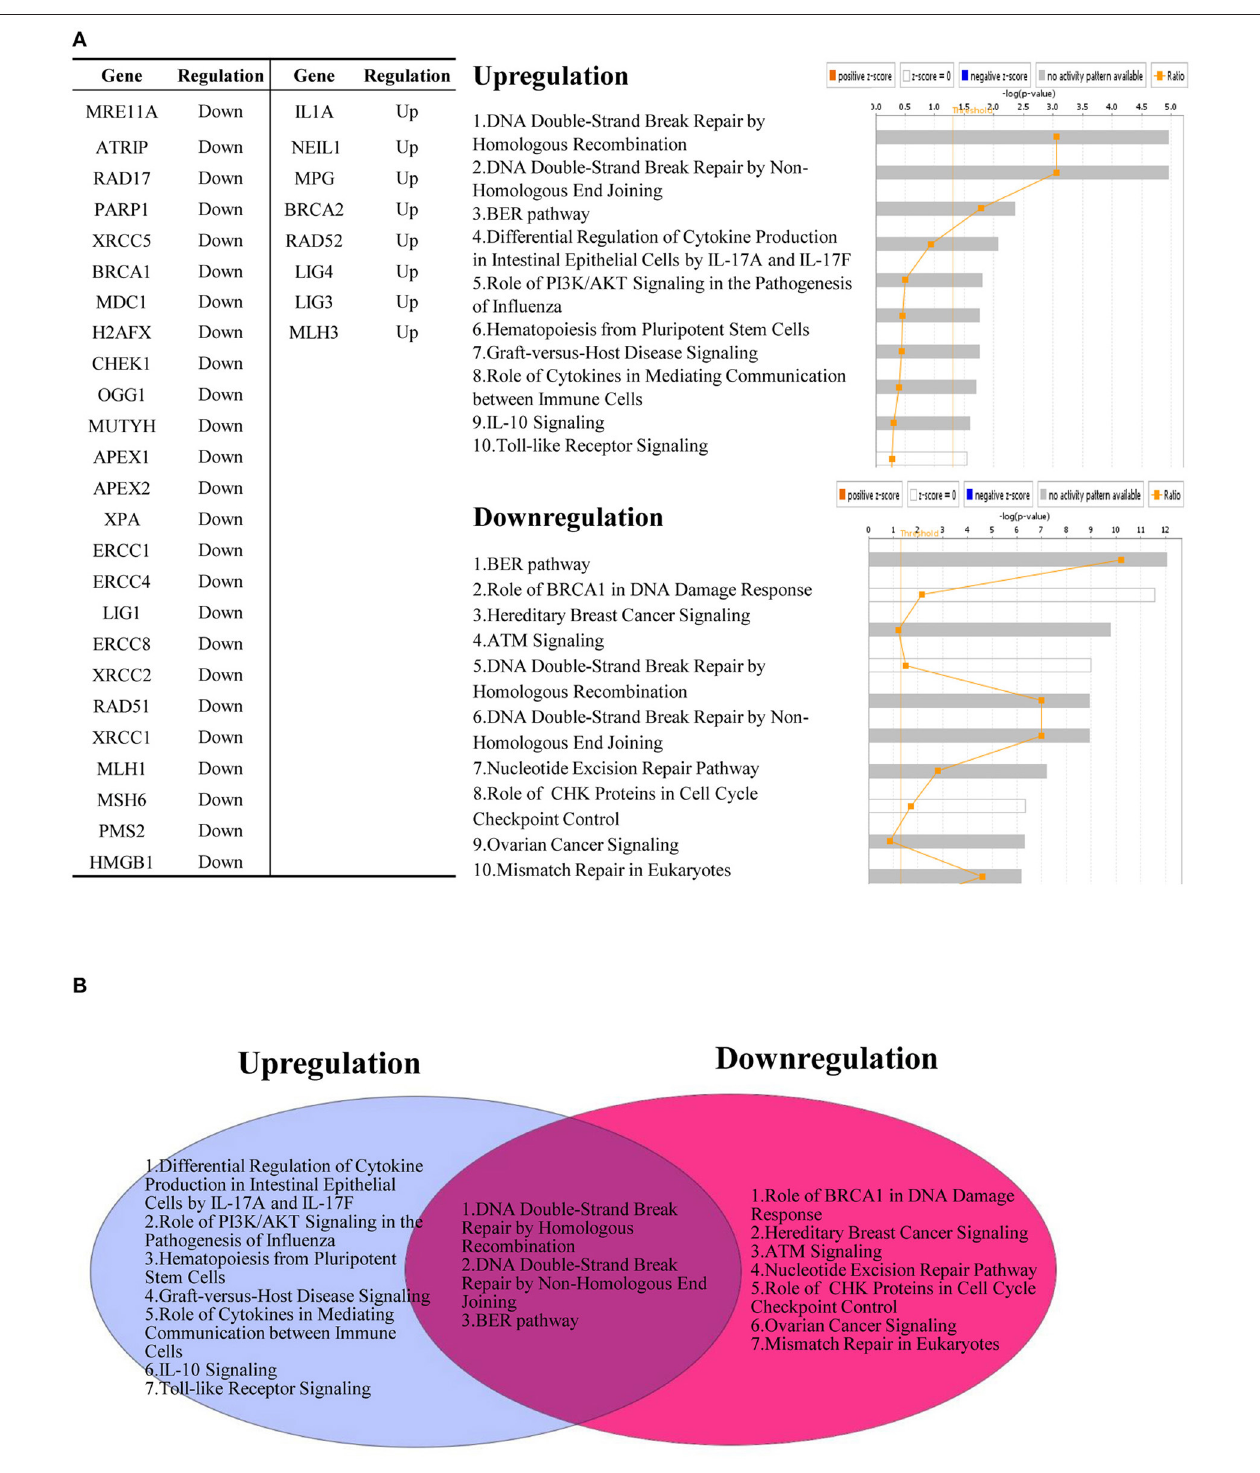
FIGURE 11 | Pro-inflammatory cytokines regulate the expression of DNA damage response factors. (A) Downregulated DNA damage response factors (25/68) and upregulated DNA damage response factors (8/68) by cytokine treatment are involved in different signaling mechanisms. (B) Three pathways are shared between upregulated and downregulated DNA damage response factors after treatment with pro-inflammatory cytokines.